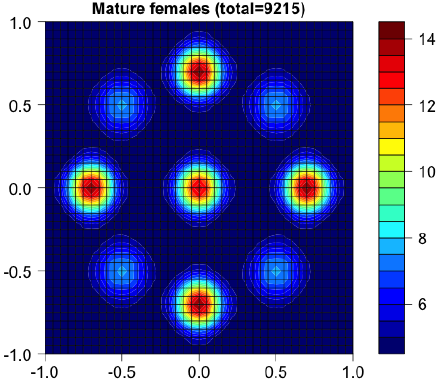
Fig. 2. Mature Females distribution with no wind, no vector control.